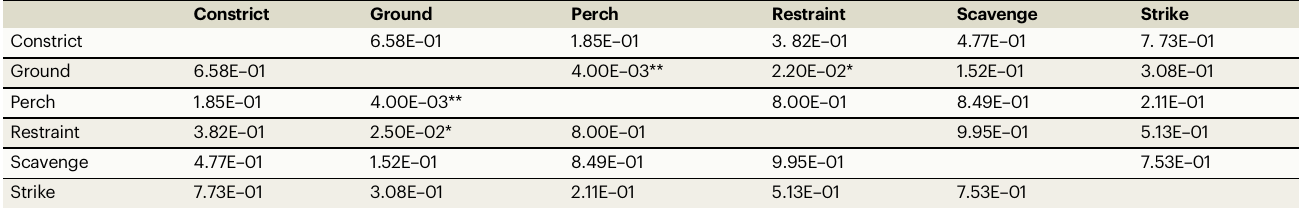
Table S1in ref.12provides data forwhen digit I informationisincluded; inclusionofdigit I does notaffectwhichgroups aresigni fi cantly different. p valuesare indicatedwithone asterisk(*) for signi fi canceatthe0.05 levelandtwo (**)at the0.01 level.Notethatthepairwise()functioninRRPP 48 placesalowerlimit onthereturned p value, so p valuesreportedas1.00E – 03 maybemore signi fi cant.Adjustments aremadeformultiple